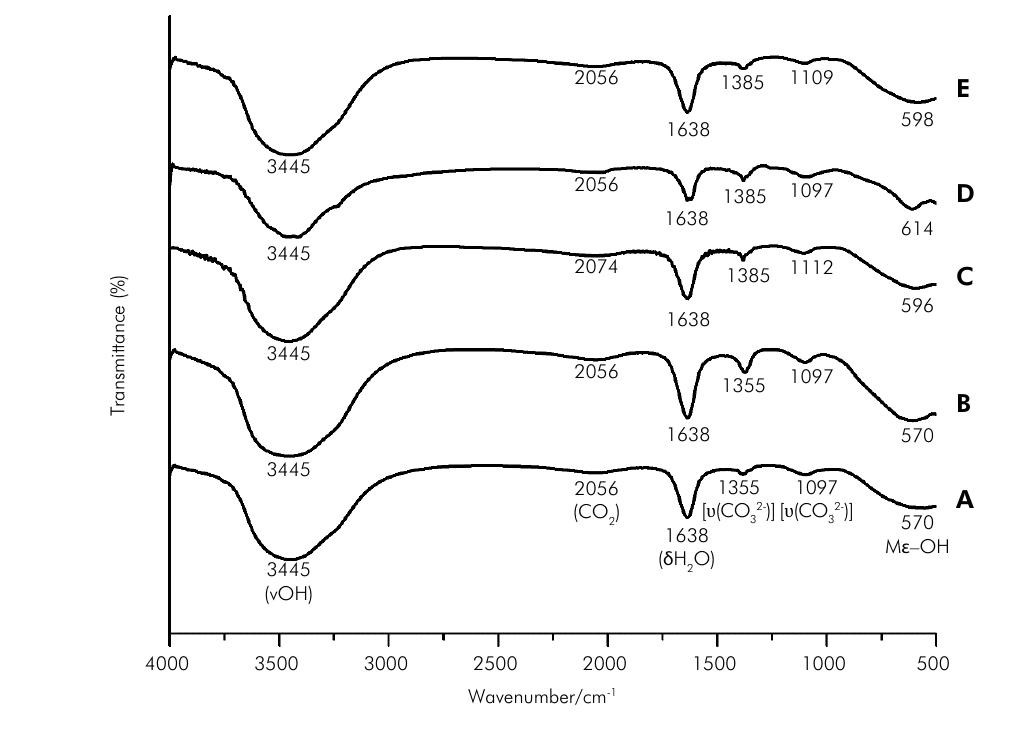
Figure 2. Infrared spectra of precursors C-LDH (A) and N-LDH (B). (C), (D), and (E) illustrate the infrared spectra of F-LDH synthesis at 25°C for 2 h. Fluoride product (F-LDH/1) synthesis from C-LDH precursor (C). Fluoride product (F-LDH/5) synthesis from N-LDH colloidal suspension (D). Fluorinated product (F-LDH/9) synthesis from N-LDH powder (E). Absorptions associated with asymmetric axial and angular deformation of the hydroxyl group ( OH- 3445 cm -1 ; δ H O- 1638 cm -1 ) bonds correspond to the adsorbed 2 and interlamellar water molecules, respectively. At approximately 2056 cm -1 , there is a band corresponding to a CO medium. 2 ʋ 1355 cm -1 and 1097 cm -1 correspond to asymmetric axial stretching and deformation mode of the carbonate anion [ (CO 32- )]. The band at 600 cm -1 is related to the metal presence. Note, for (C), (D), and (E), the corresponding fluoride products showed a ʋ higher band frequency relative to CO 32- (1385 cm -1